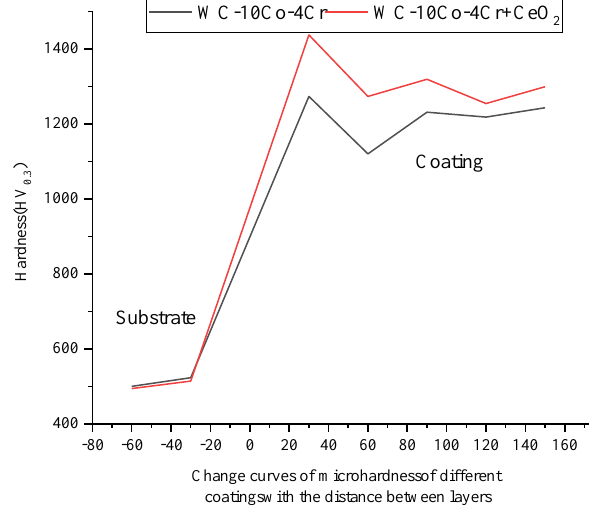
Figure 7. Microhardness of WC-10Co-4Cr coating and WC-10Co-4Cr+CeO 2 coating. Table 2. Porosity of WC-10Co-4Cr and WC-10Co-4Cr+CeO 2